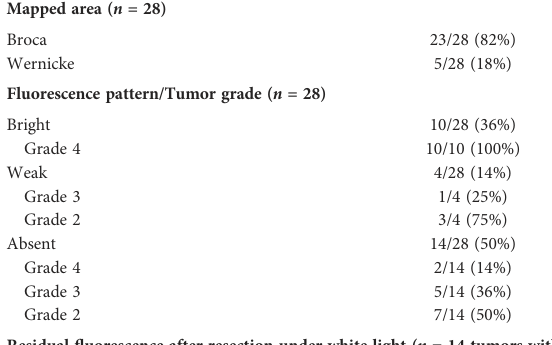
TABLE 1 Patients with cortical mapping only (prior to 2016), n =